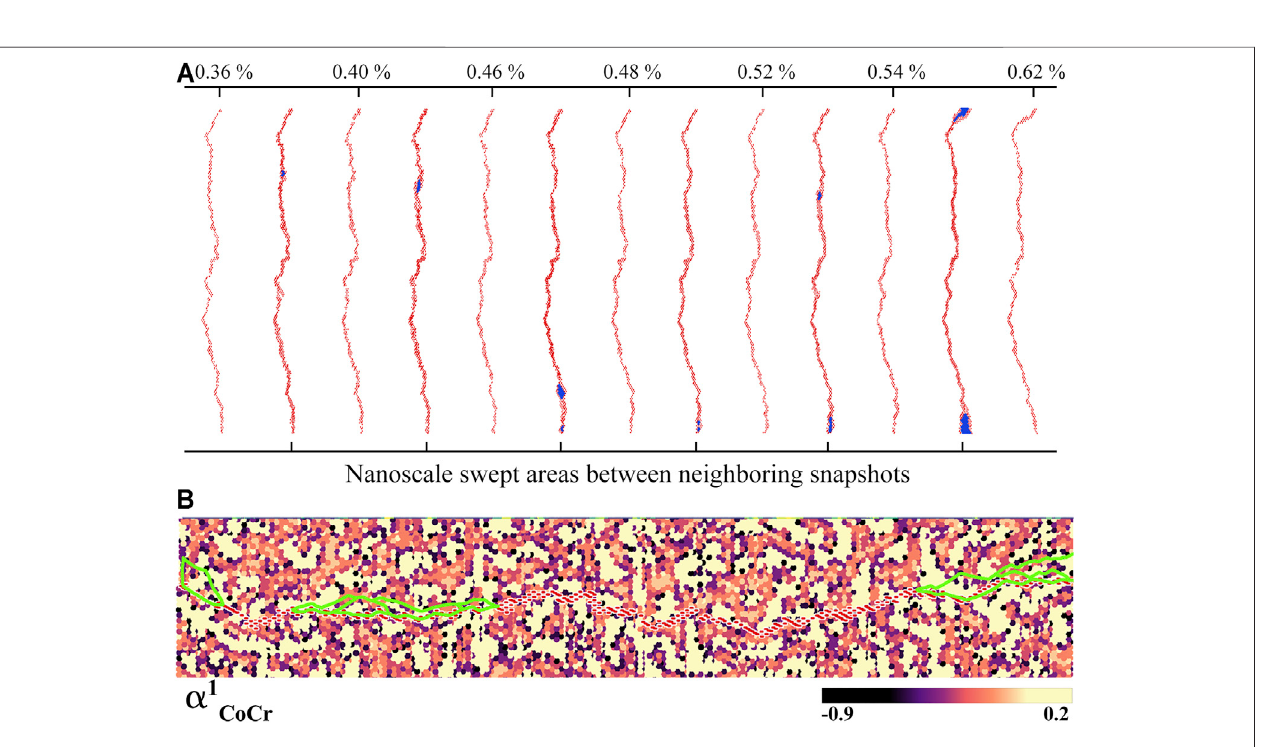
Frontiers in Materials |